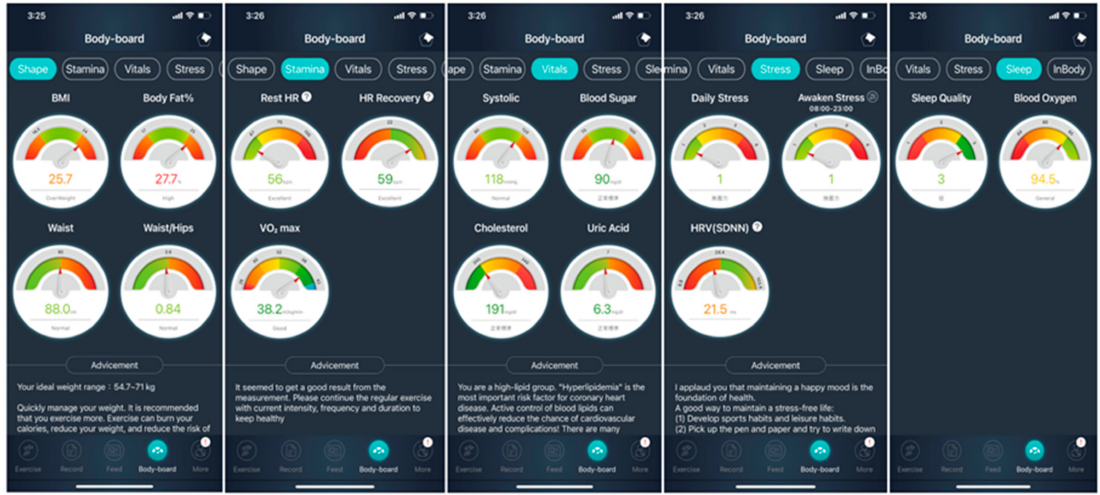
Figure 3. User interface of human dashboard from